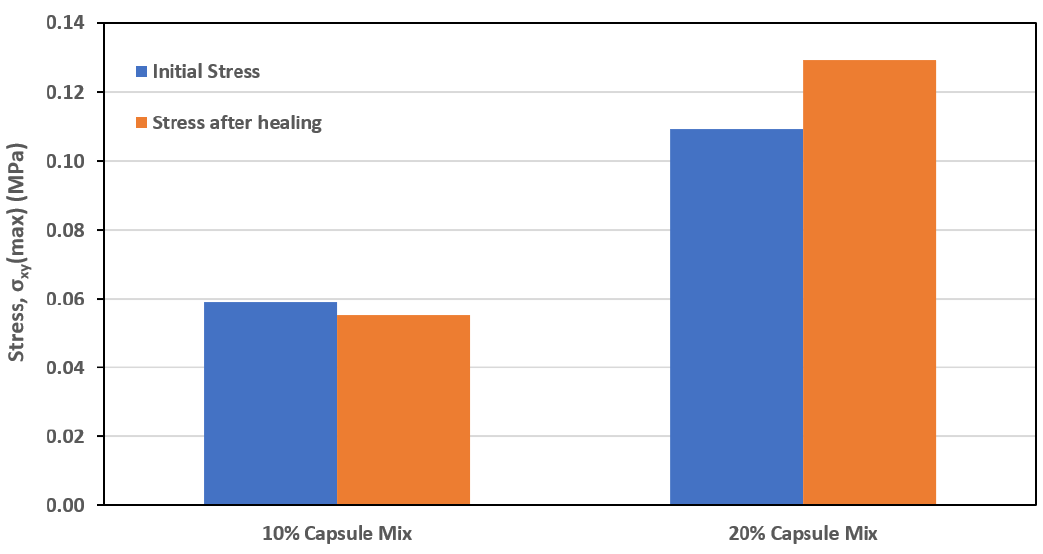
Figure 22. Bitumen ITS and induction healing test results.